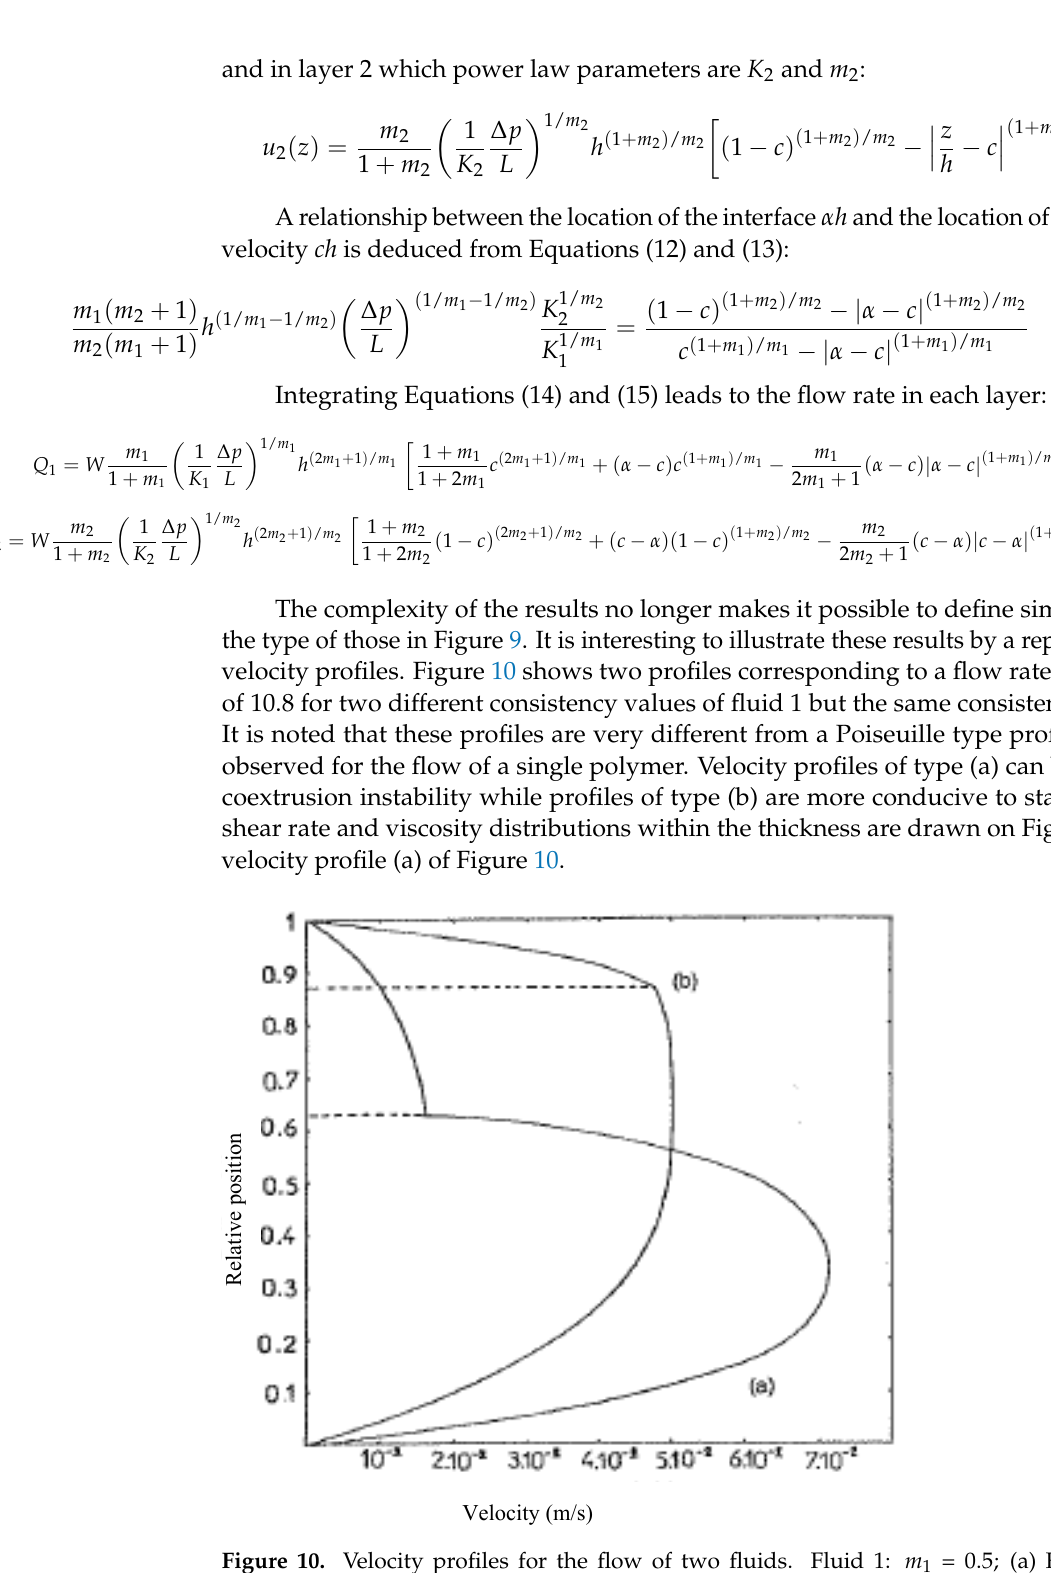
Figure 10. Velocity profiles for the flow of two fluids. Fluid 1: m 1 = 0.5; (a) K1 = 10 3 Pa · s n ; (b) K1 = 10 4 Pa · s n . Fluid 2: m 2 = 0.3; K2 = 10 2 Pa · s n (Reprinted from Ref.